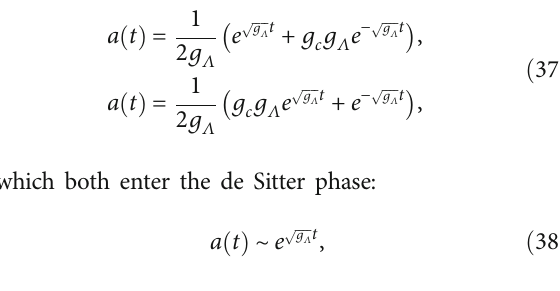
= 1 , g = 2 , C = 1 , λ = 1 , m = 2 , and ϕ c r s